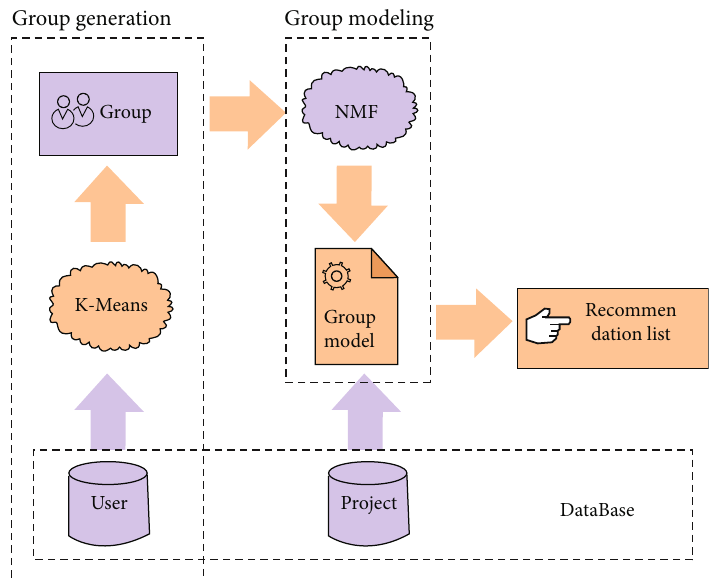
Figure 3: GRBNMF algorithm framework.